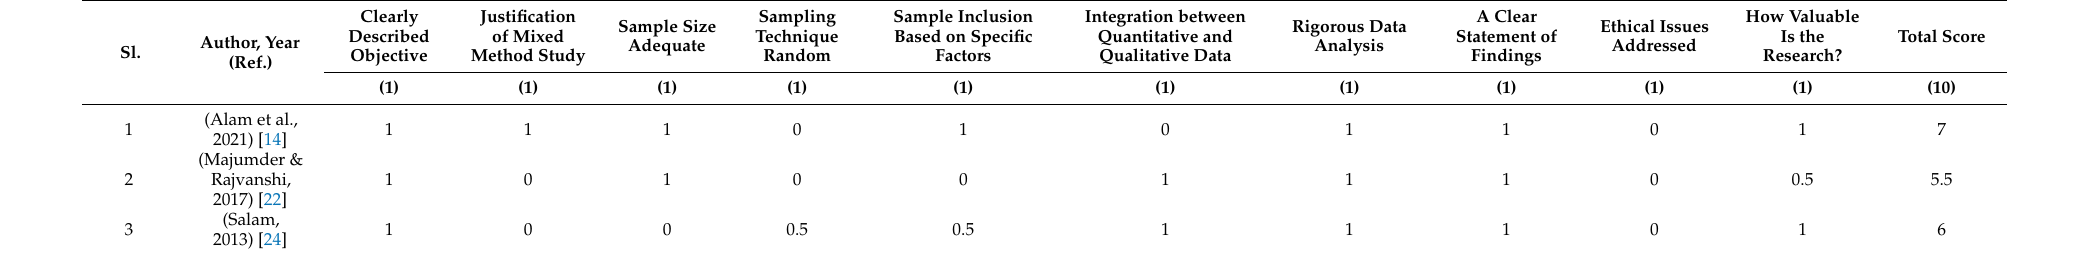
Table A4. Mixed Method